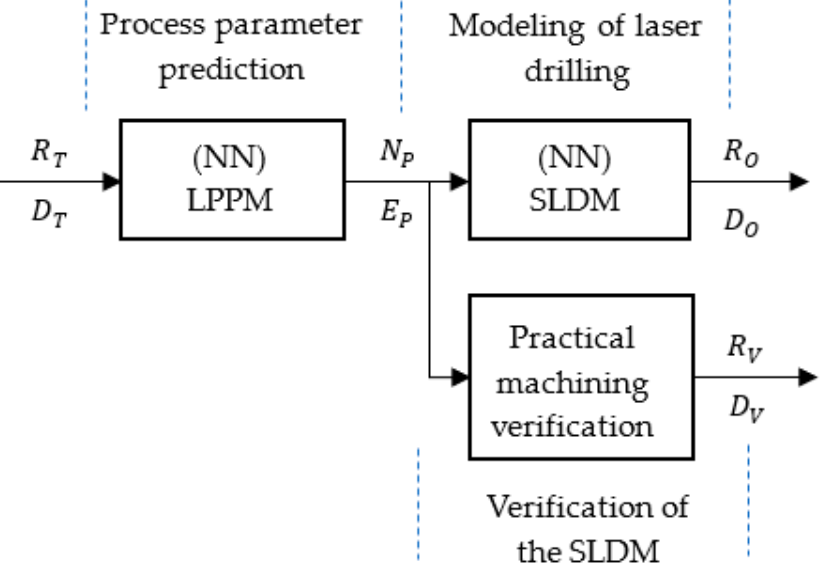
Figure 4. Methodological flow chart for parameter prediction and modeling of laser drilling, and its verification.